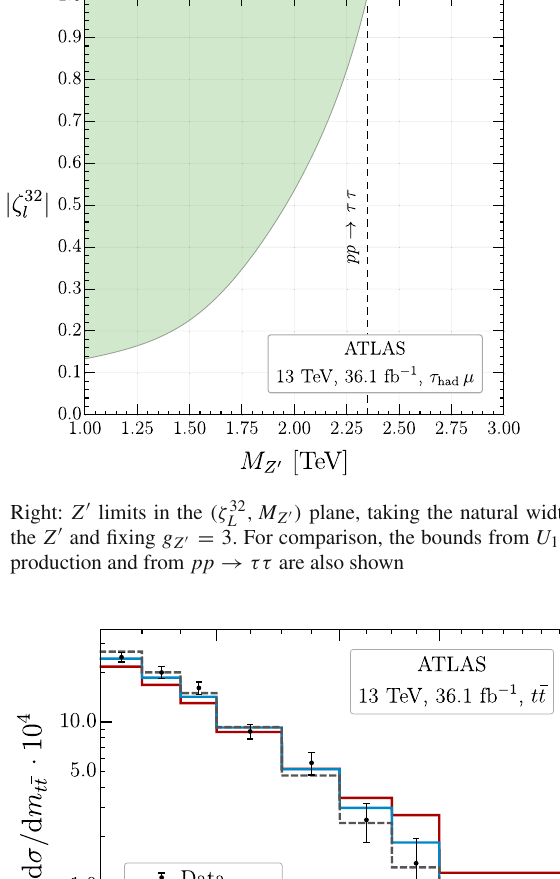
widths of the coloron. The different curves (solid, dashed, dotted) show various different choices of relations between the couplings to left- and right-handed light quarks. As expected, limits get weaker with increasing width of the